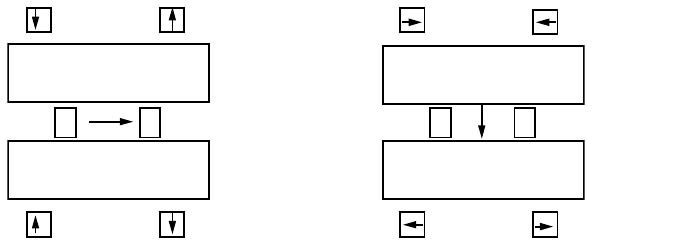
FIG. 7. Schematic end view of the VISA undulator, showing placement of shim magnets in groups of four. With magnetizations arranged as at left, the shim magnets create a net horizontal field on axis, and on the right they create vertical field. By varying the vertical positions of these magnets, we obtain a tuning range of about 3–35 G cm.